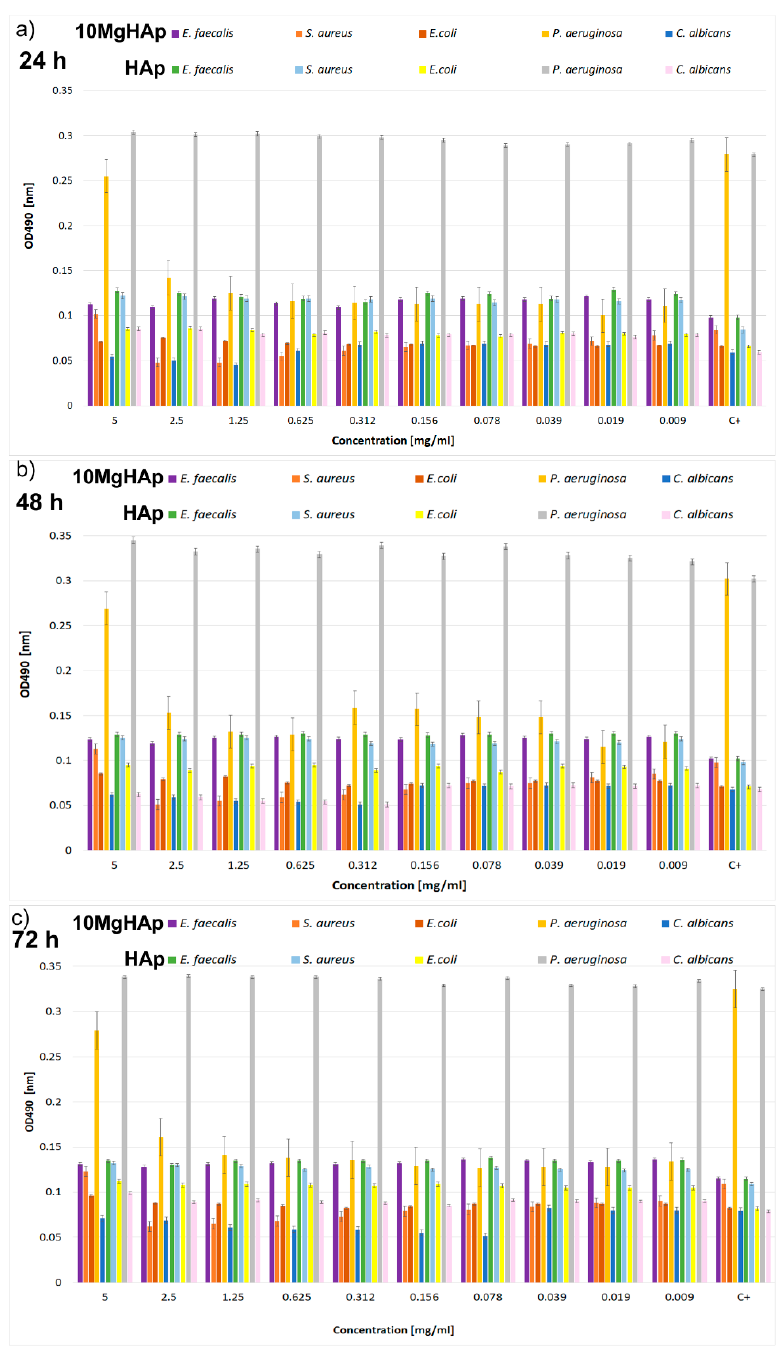
Figure 12. The dynamics of the antimicrobial activity of 10MgHAp and HAp against Enterococcus faecalis ATCC 29212, Staphylococcus aureus ATCC 25923, Escherichia coli ATCC 25922, Pseudomonas aeruginosa ATCC 27853, and Candida albicans ATCC 90029 microbial cells after ( a ) 24 h, ( b ) 48 h, and ( c ) 72 h of incubation.